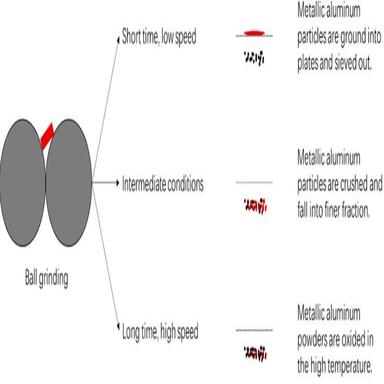
Schematic sketch on grinding and sieving processes through the mechanical treatment.